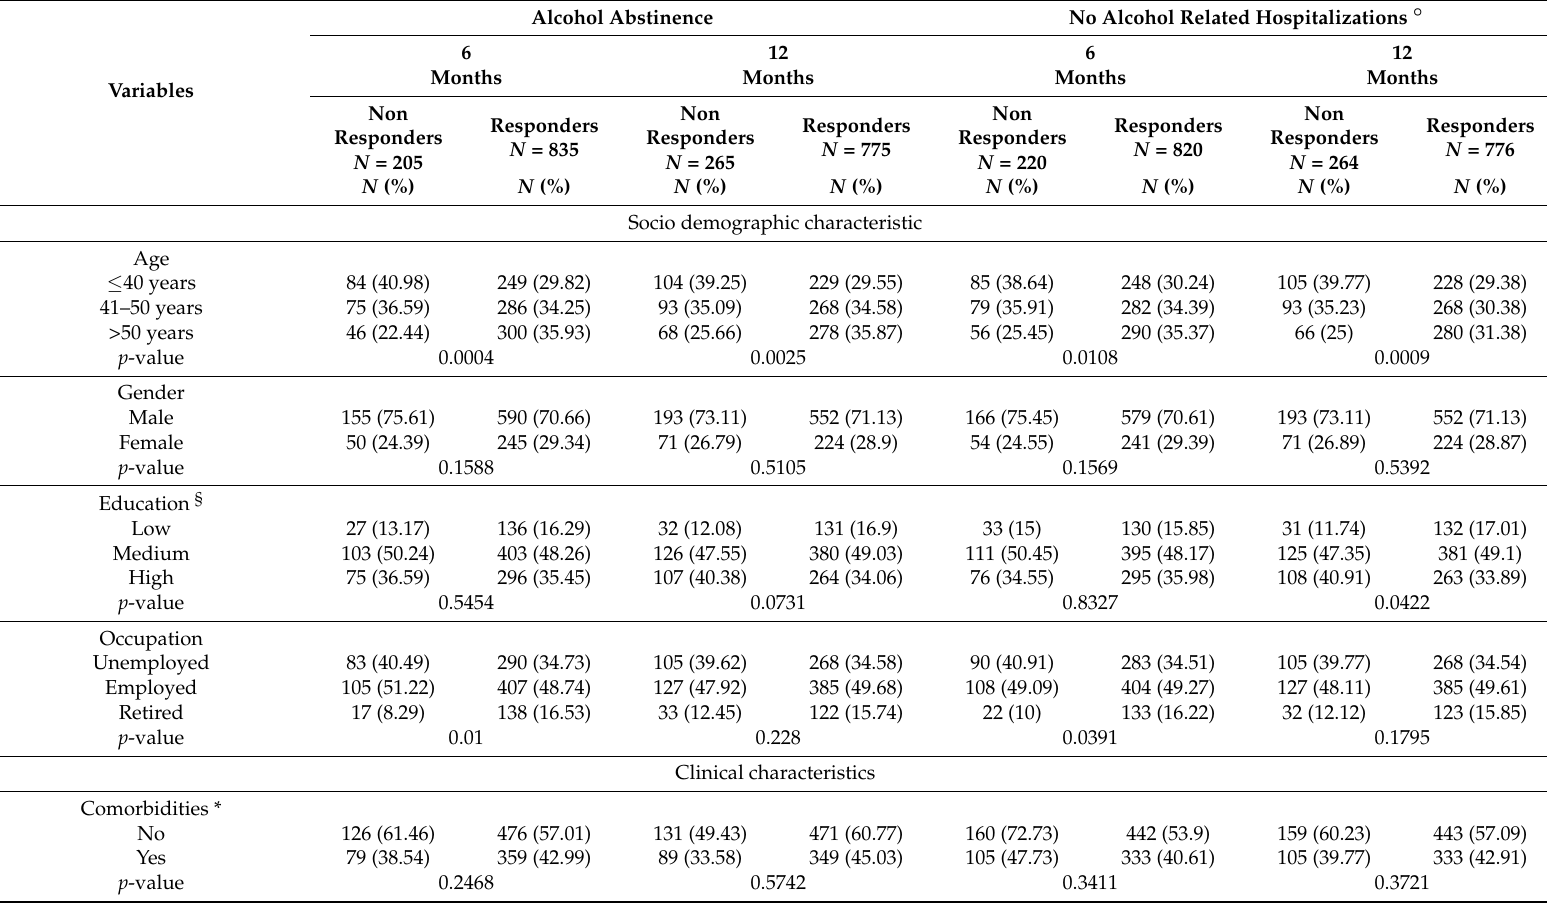
Table 1. Distribution of responders and association with several socio demographic and clinical characteristics and the number of treatment’s strategies at 6 and 12 months for alcohol abstinence and no alcohol related